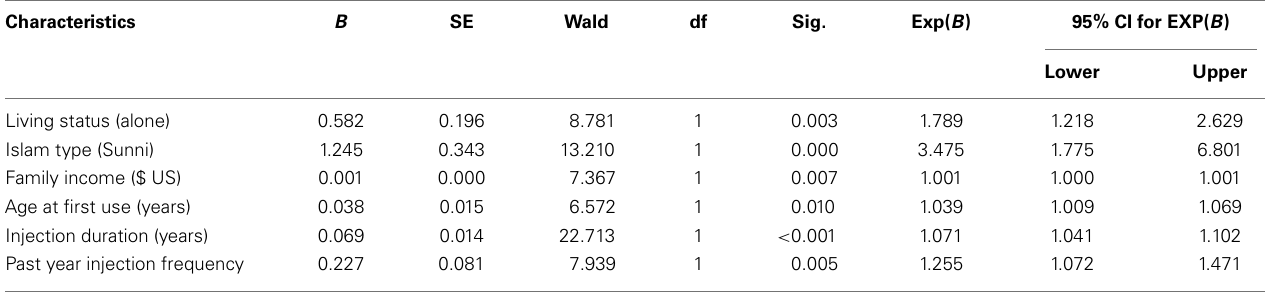
Table 2 | Regressors of non-arm injection among Iranian IDUs ( n =